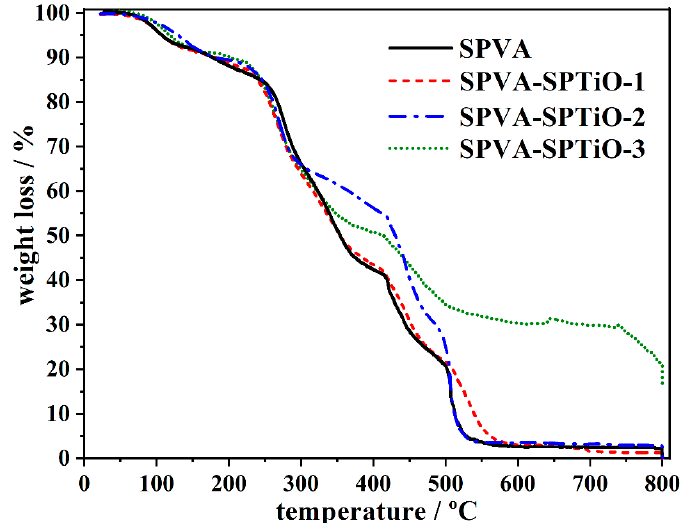
Figure 7. TGA curves of the fabricated membranes.